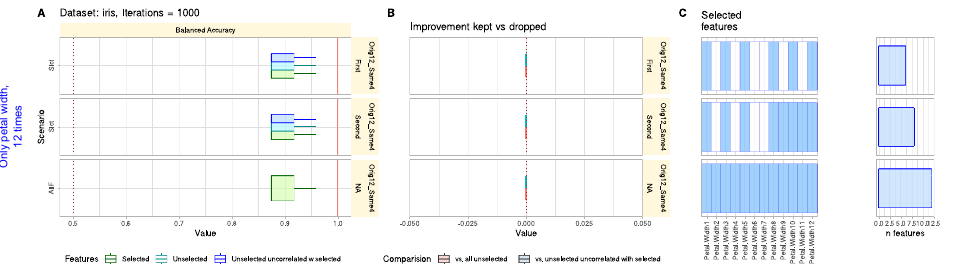
Figure 4. Feature selection and classification performance evaluation with different feature sets in the iris data set [28]. Experiments were performed only on petal width, added 12 times to the data set. The graph is organized in three subgraphs, showing from top to bottom (i) the results when using the features selected in the default feature selection, (ii) the features added when performing a second feature selection on the unselected features from the first selection, and (iii) when training the algorithm with the full feature set. The boxes show the 25th, 50th (blue vertical line), and 75th percentiles of balanced accuracies obtained in 1000 repeated runs with a random selection of 67% from the training data set and 80% from a validation data set separated from the data set before feature selection. Whiskers span the 95% confidence interval from the 2.5th to the 97.5th percentiles. ( A ): Balanced accuracy obtained with a random forests classifier trained with (i) the selected features, (ii) the unselected features, and (iii) the unselected features that were not highly correlated with the selected features, with the correlation threshold set at a very strong correlation of ρ > 0.9. ( B ): Difference in balanced accuracy when algorithms were trained with the selected versus unselected features. ( C ): Selected features (blue) and unselected features